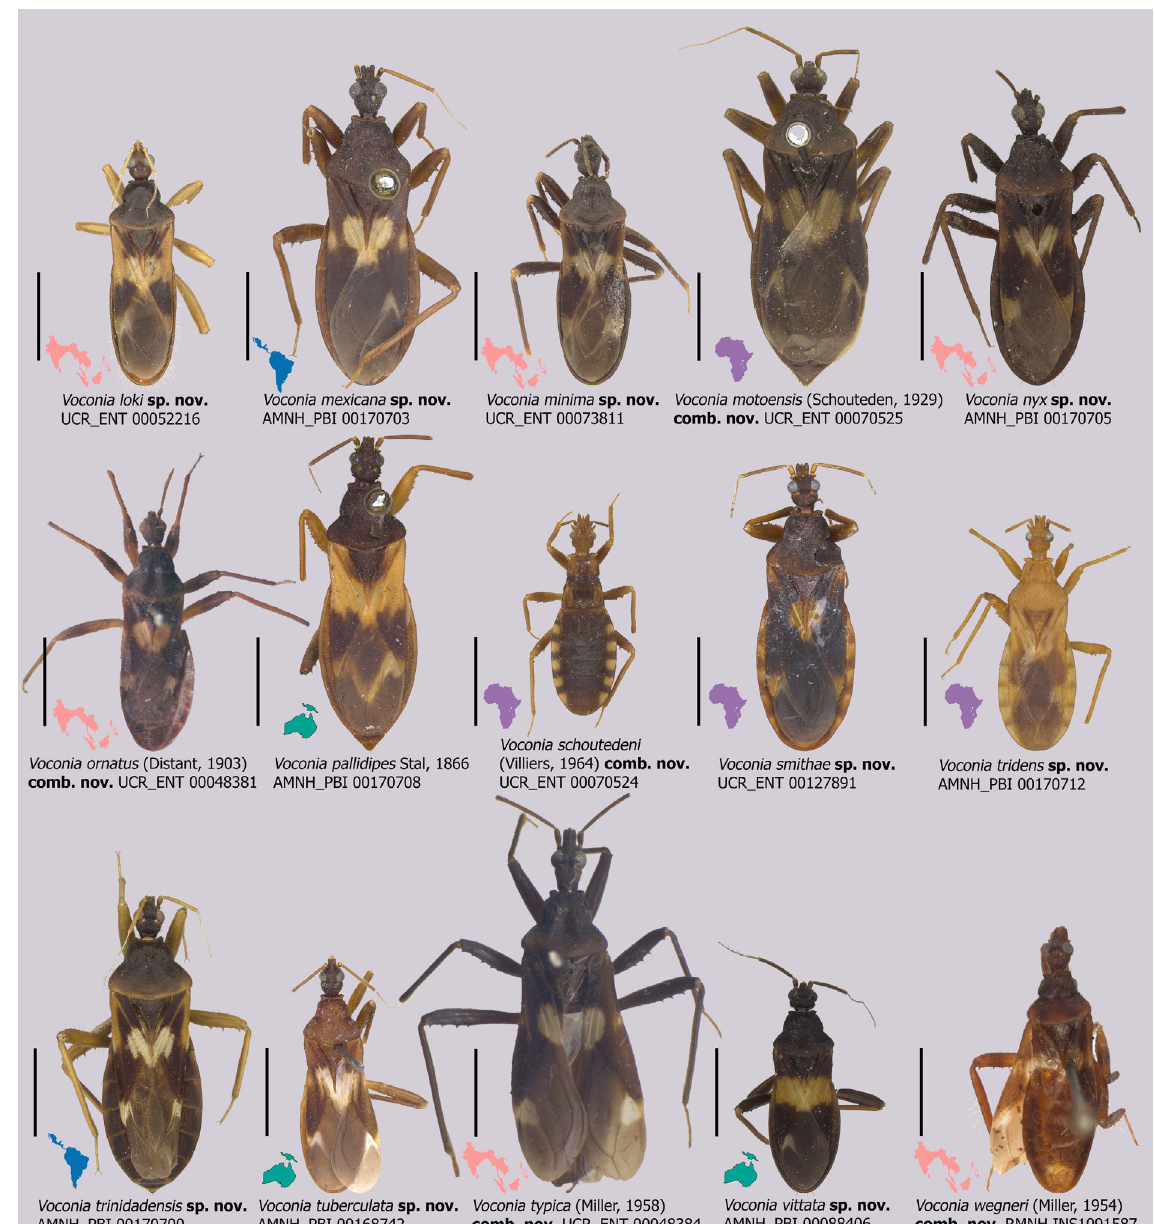
Fig. 8. Dorsal habitus of holotypes of Voconia Stål, 1866 species with distribution: purple = Afrotropical region, green = Australasian region, blue = Neotropical region, pink = Oriental region. Scale bars = 3